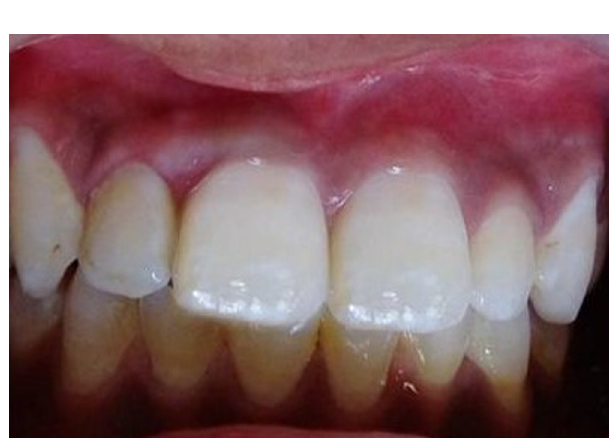
Fig. 5. Post operative clinical photograph at four year follow